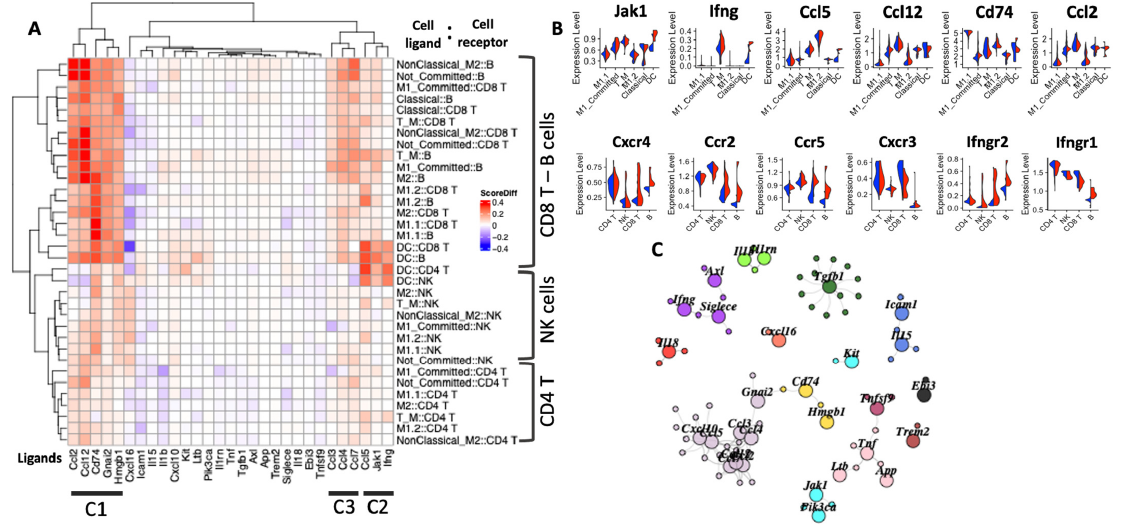
Figure 5. Ligand–receptor analysis. ( A ) Heatmap representing the difference in score between the control and MCTP39- treated samples. Red and blue cells denote that scores are higher or lower, respectively, following MCTP39 treatment and indicate a potential increase in cell-to-cell communication via a specific ligand–receptor interaction. Ligands are assumed to be produced by myeloid cells (see previous results), and the top changing ligands are listed at the bottom. The row names indicate the cell pair considered. The most represented receptor-expressing cell types are highlighted on the right side. ( B ) Violin plots showing the expression levels of the ligand and receptors for the top results shown in the heatmap. Cell types are shown on the x axis. ( C ) Cluster analysis of the ligand–receptor groups representing an overview of the multiple ligand–receptor interactions possible. Colors indicate different clusters.